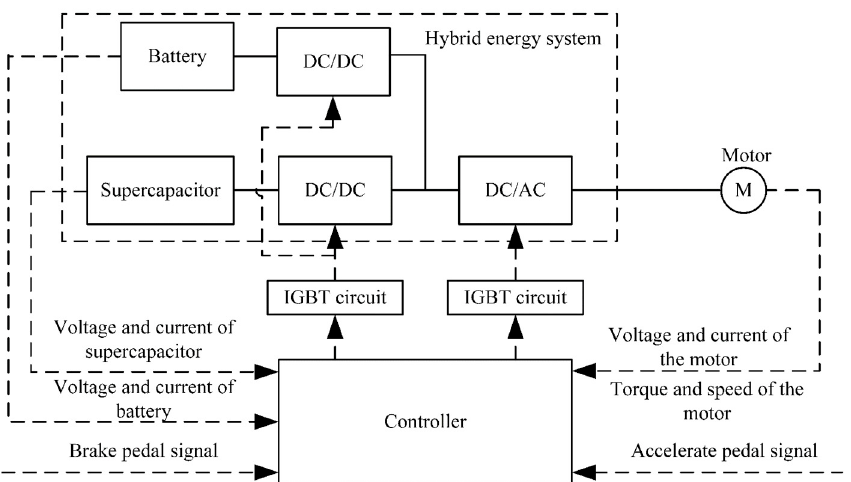
Figure 6. The control schematic diagram of the HES.